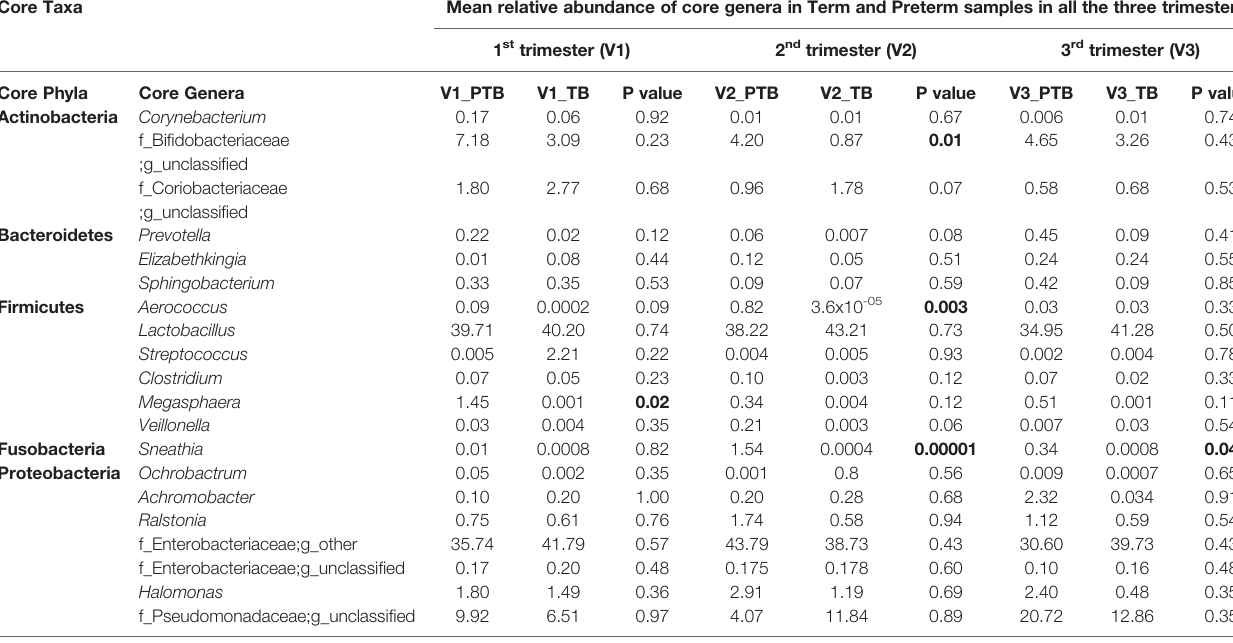
p-values in bold letters are considered to be statistically signi fi cant (p<0.05).